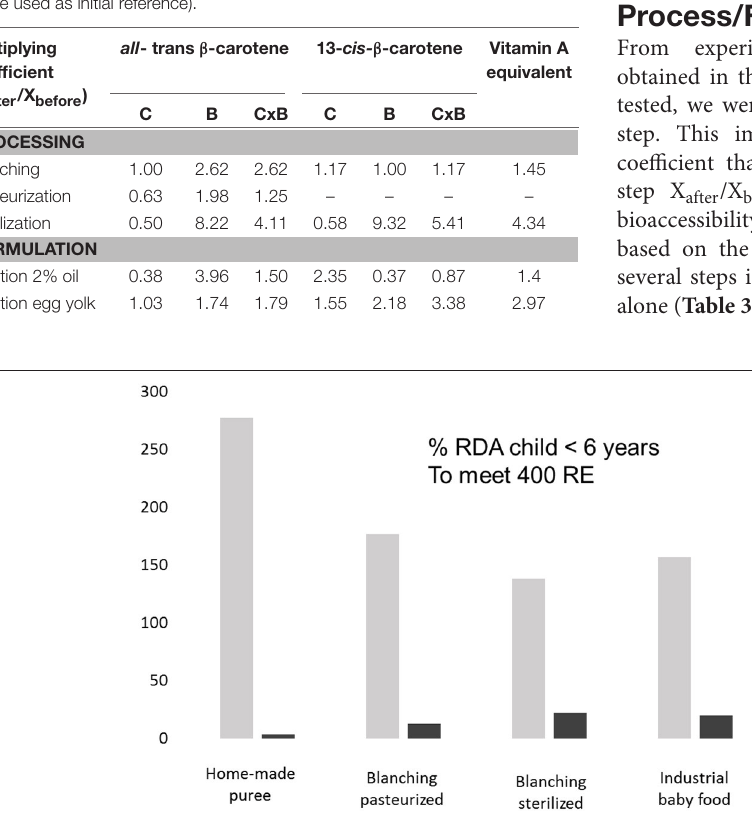
FIGURE 5 | Differences between estimates of vitamin A (% RDA child < 6 years) in 115g portion OFSP processed purees using classical estimate RAE from food (Retinol Activity Equivalent- µ g trans - β -carotene/12 and 13- cis - β -carotene/24) and estimate taking into account bioaccessibility (calculated with RE: Retinol Equivalent µ g trans - β -carotene/6 and 13- cis - β